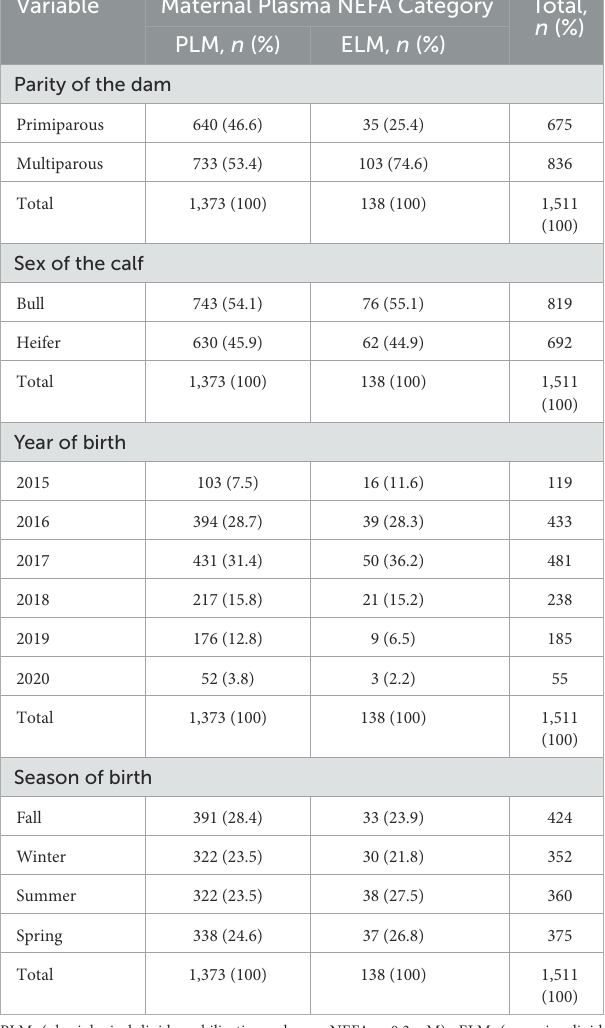
TABLE 1 Descriptive statistics for predictor variables organized by maternal plasma NEFA category in the late gestation. Variable